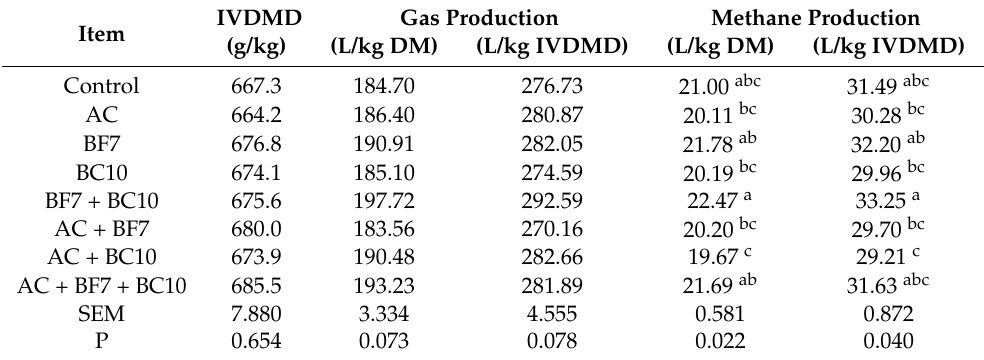
Table 5. In vitro rumen fermentation after 24 h incubation of the dietary TMR prepared with cassava root silage (50:50 w / w